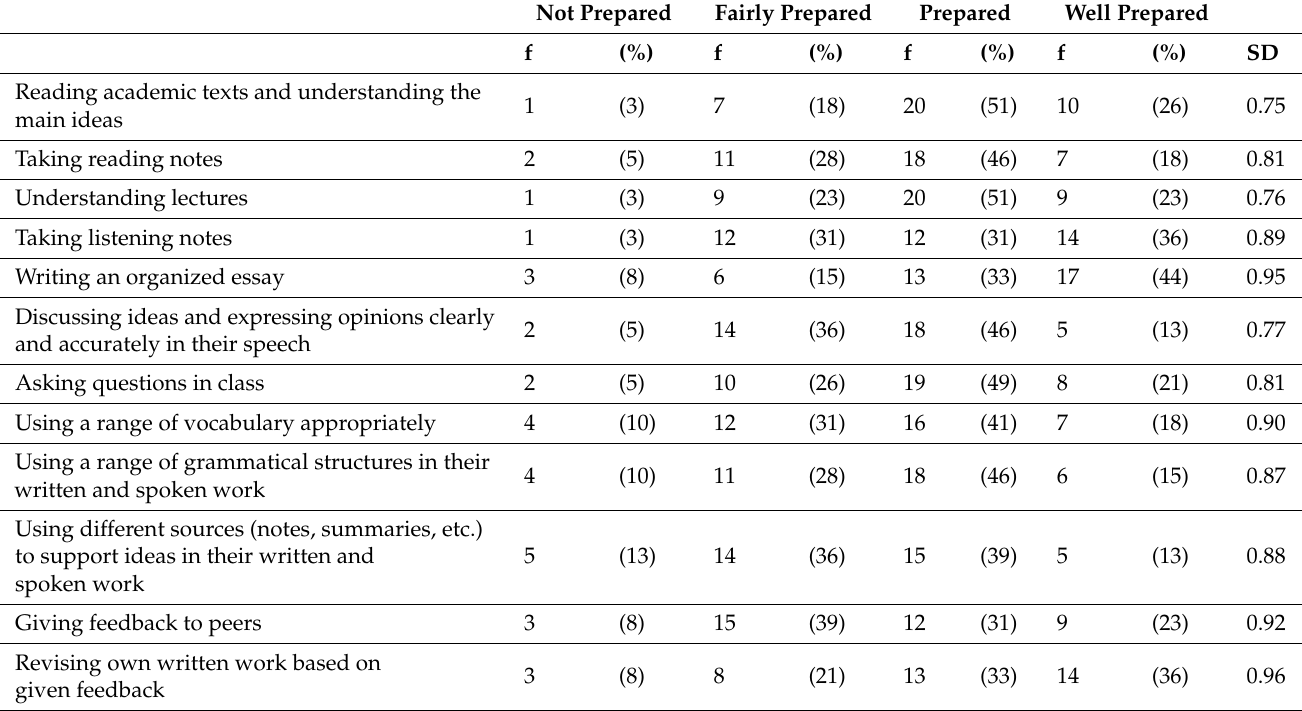
Table 3. Summary of student perceptions (N =